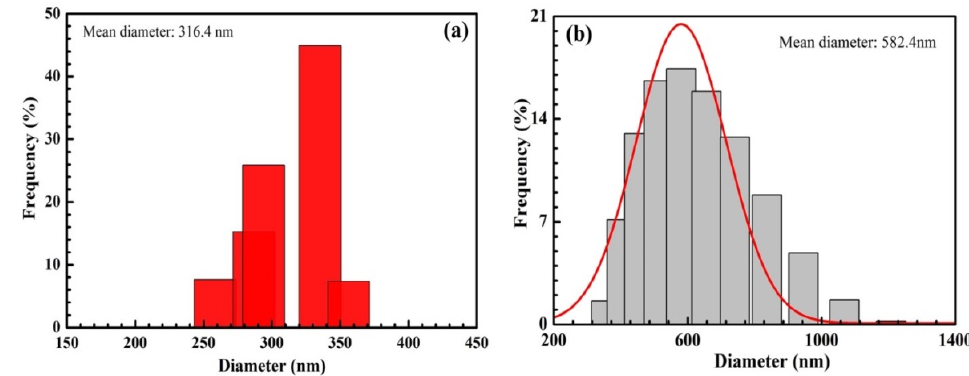
Figure 7. Dynamic Light Scattering results of SiO 2 ( a ) and SiO 2 @Au ( b ).